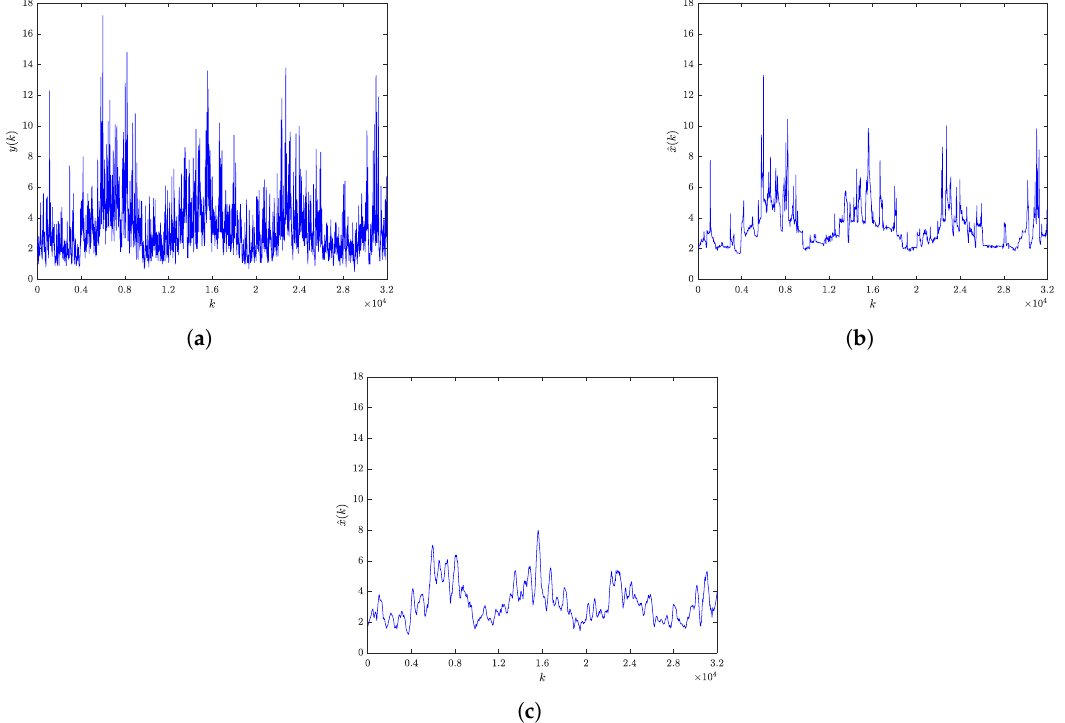
Figure 10. Significant wave height: ( a ) Noisy measured signal. ( b ) RBF-RICI filtered signal. ( c ) Savitzky–Golay filtered signal. Figure 11a shows the noisy measurements of the wave direction (°), whereas Figure 11b shows the wave direction signal obtained after applying the RBF-RICI filtering algorithm, whose parameters are tuned to the values Γ = 0.6 and R c = 1. Figure 11c shows the signal obtained after application of the Savitzky–Golay